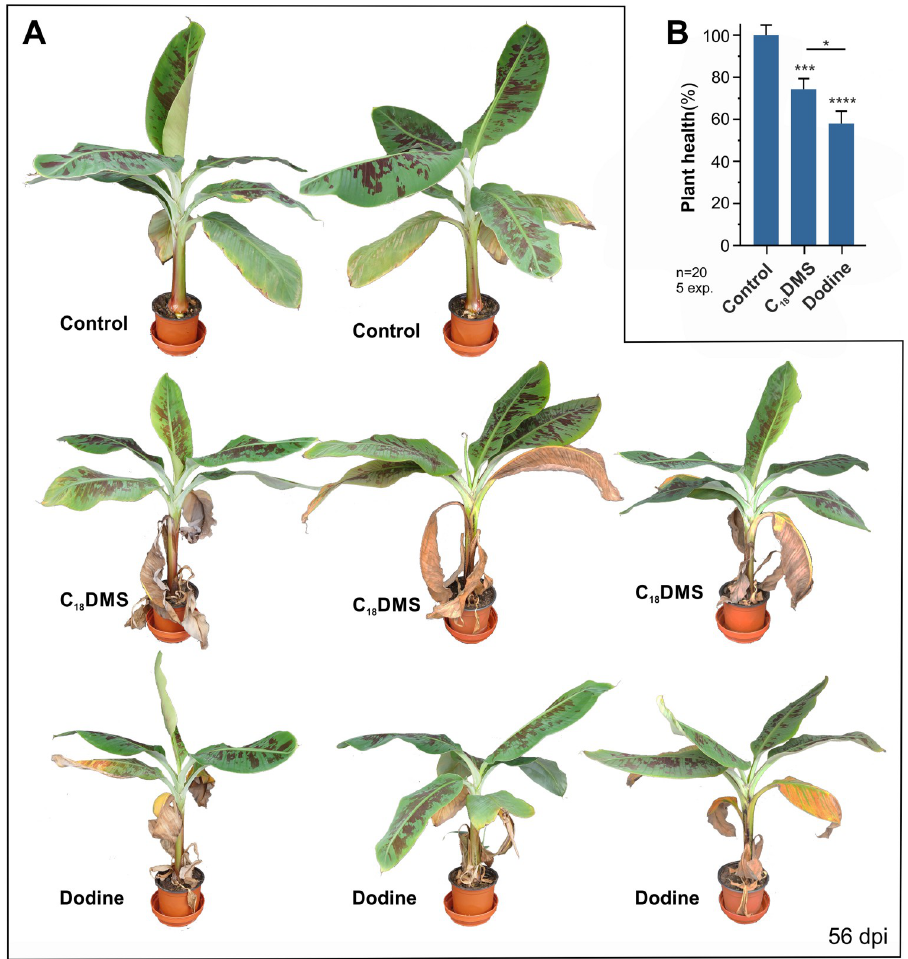
Fig 8. Protective effect of C 18 DMS and dodine in FocTR4-infected bananas. A Cavendish banana plants, infected with FocTR4 chlamydospores, at 56 days after 2 treatments (day 0 and day 7) with C 18 DMS, dodine or solvent control (0.16% MetOH (v v -1 )). B Bar chart showing plant health, assessed by measuring all aerial tissues in photographic images of 56 d-old plants, infected with chlamydospores and treated twice with C 18 DMS or dodine. Control indicates healthy plants (100% plant health) that were not infected by FocTR4, but which were treated with the solvent methanol. Data in ( B ) are given as mean ± SEM; sample sizes indicated in graph; statistical comparison with control and between data sets used Student’s t-testing with Welch correction; � = significant difference at two-tailed P = 0.0480; ��� = significant difference at two-tailed P = 0.0007; ���� = significant difference at two-tailed P < 0.0001. Treatments were solvent control: 0.16% MetOH (v v -1 ), dodine: 200 μ g ml -1 and C 18 DMS: 200 μ g ml -1 .